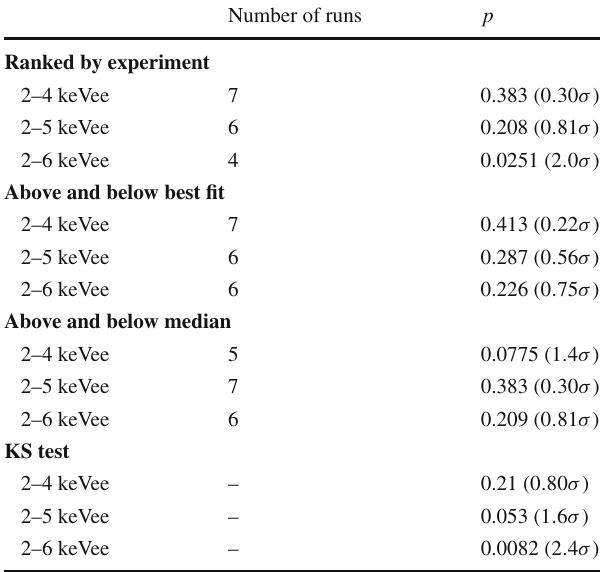
Table4 Resultsfortheruntestaspresentedbythecollaborationandfor the tests we have performed as described in the text. The corresponding p -value is for a hypothesis test where the null hypothesis is taken to be the case where the two iterations of the experiment are drawing measurements from the same distribution Number of